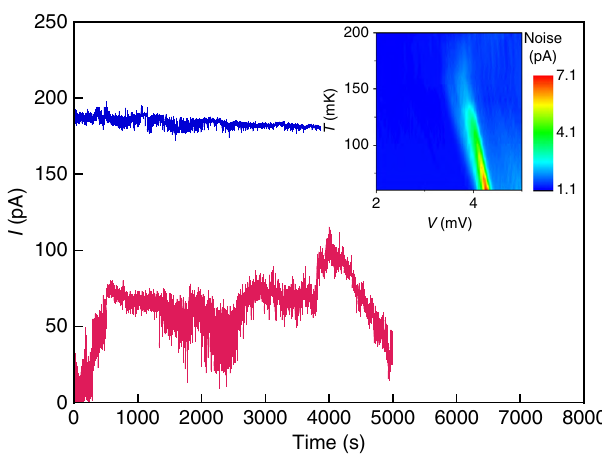
Fig. 2 The current as a function of time. Current is plotted as a function of time for n s = 5.2 × 10 10 cm − 2 and T = 60 mK at voltages V = 4.90 mV (which lies between V th1 and V th2 ; lower curve) and V = 5.44 mV (above V th2 ). Inset: colour map of the broad-band noise at on a ( V , T ) plane